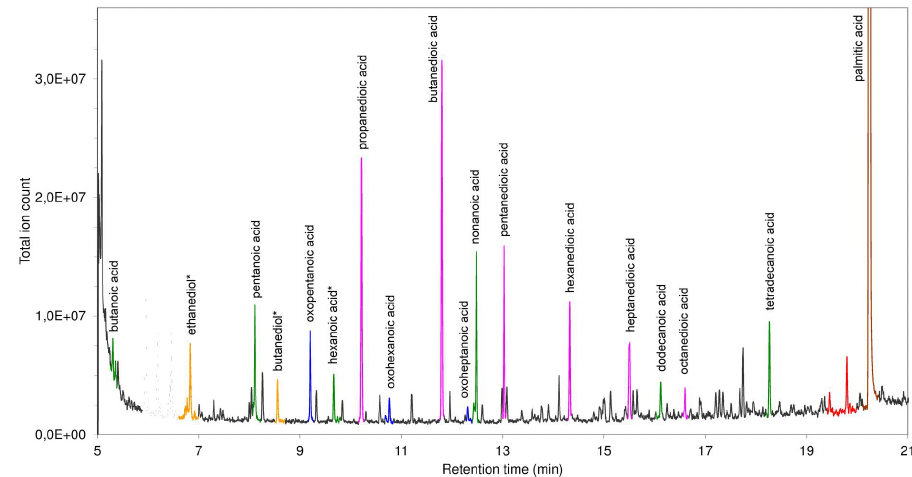
Fig. 6. Chromatogram of the silylated products from the Cl-initiated oxidation of PA in the presence of O 2 ( ∗ uncertain Figure 6. Chromatogram of the silylated-products from the Cl-initiated oxidation of PA in the 3 presence of O 2 (* uncertain identification). 4